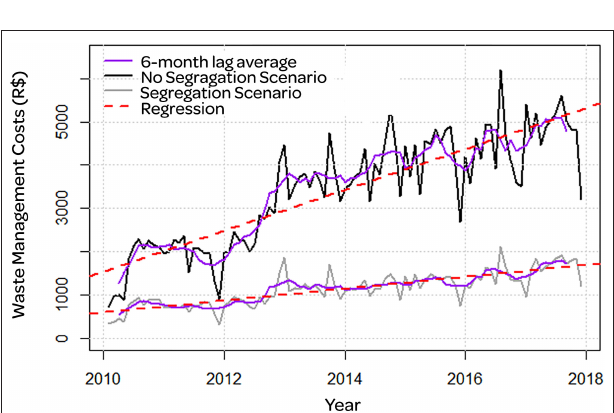
FIGURE 3 | Costs associated with incineration in the scenario with waste segregation (gray line) and in the scenario without segregation (black line). Moving averages filter with 6 months lag (purple line) and regression line (red dashed line). Costs are expressed in brazilian currency